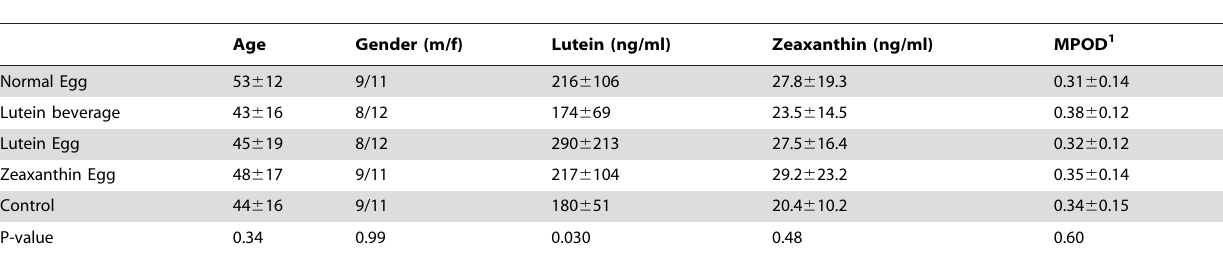
Table 2. Baseline characteristics of study subjects (mean 6 standard